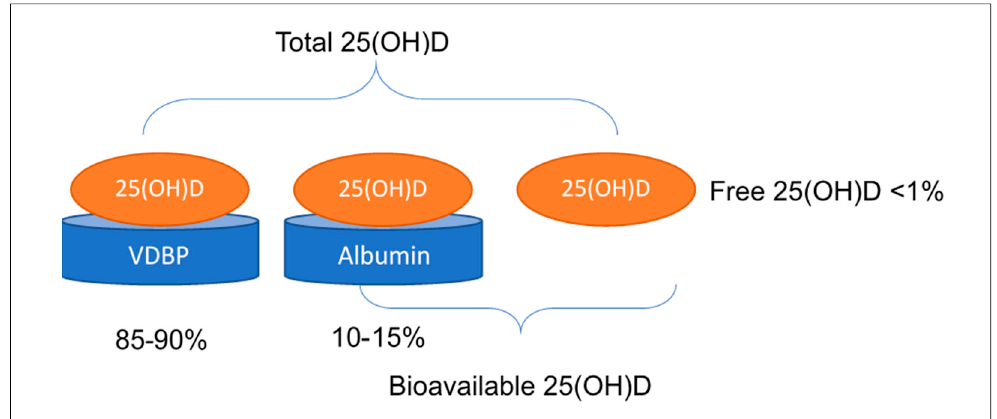
Figure 1. Differentiating between proportions of free, bioavailable and total 25(OH)D in serum: total 25(OH)D reflects 25(OH)D which is bound to vitamin D binding protein (VDBP; approximately 85%–90% of total 25(OH)D) as well as 25(OH)D bound to albumin (10%–15% of total 25(OH)D) and that which circulates free (<1% of total 25(OH)D). Bioavailable vitamin D refers to the sum of free and albumin-bound 25(OH)D (i.e., that which is not bound to VDBP).